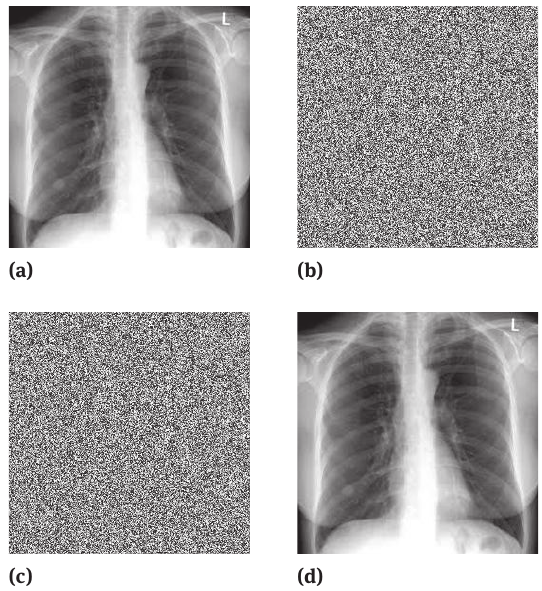
Fig. 4: Lung cancer: (a) Original image, (b) Ciphered image, (c) Stego-image, (d) Decrypted image. Table 2: Resistance for